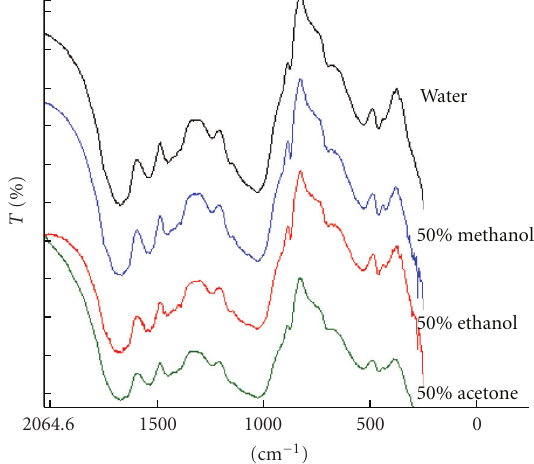
Figure 3: IR spectra of biomass in di ff erent solvents.